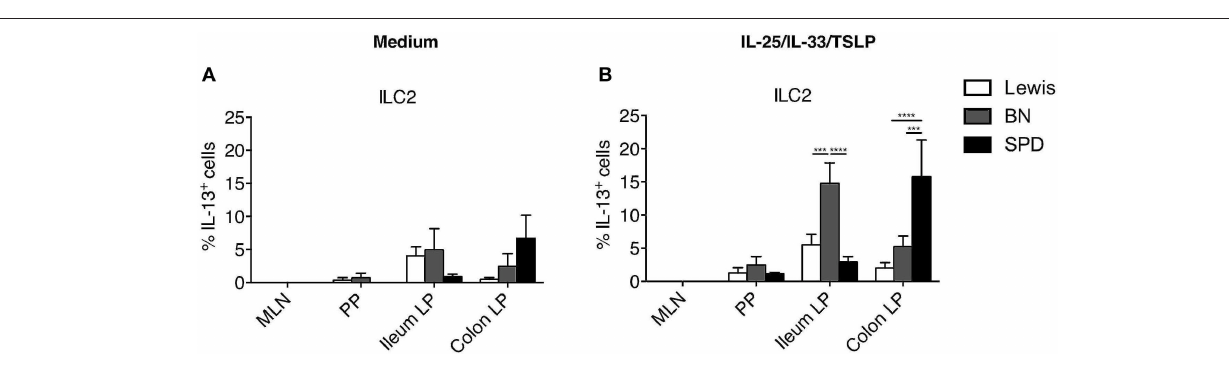
(53) also held true in rats. In line with previous results, the expression of androgen receptor (AR) was restricted to ILC2 in our scRNAseq data ( Supplementary Figure 2B ). Androgen signaling was shown to limit ILC2 proliferation in mouse males (53). We did not observe different frequencies of total ILCs and ILC2 between male and female rats in the gut (data not